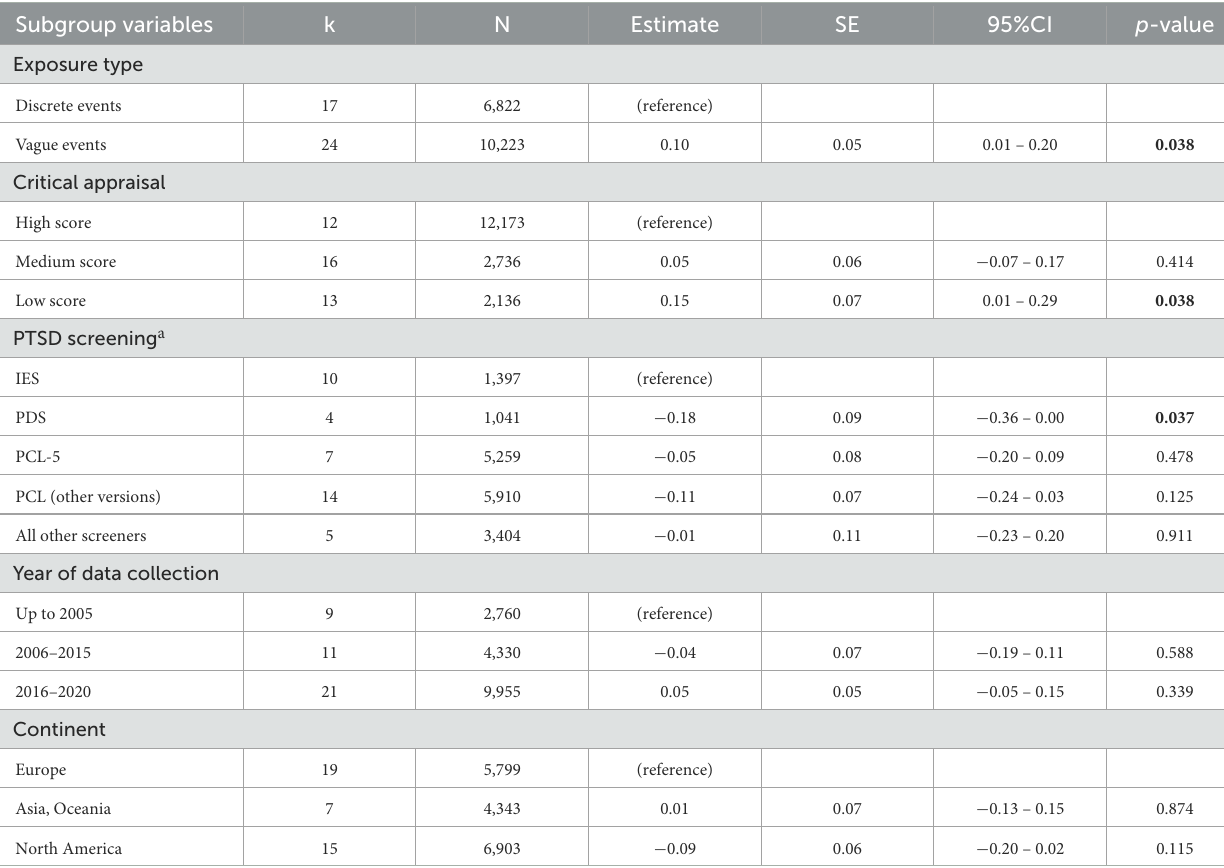
TABLE 1 Estimated pooled prevalence rates of PTSD in paramedics by subgroup